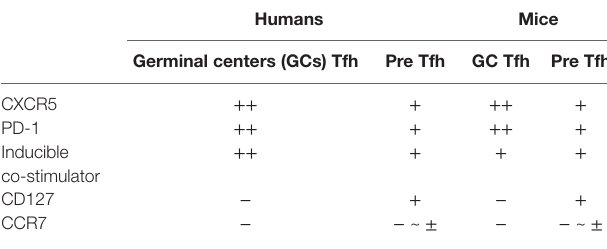
TAbLe 1 | Cell surface makers commonly used to define T follicular helper (Tfh) subsets in lymphoid